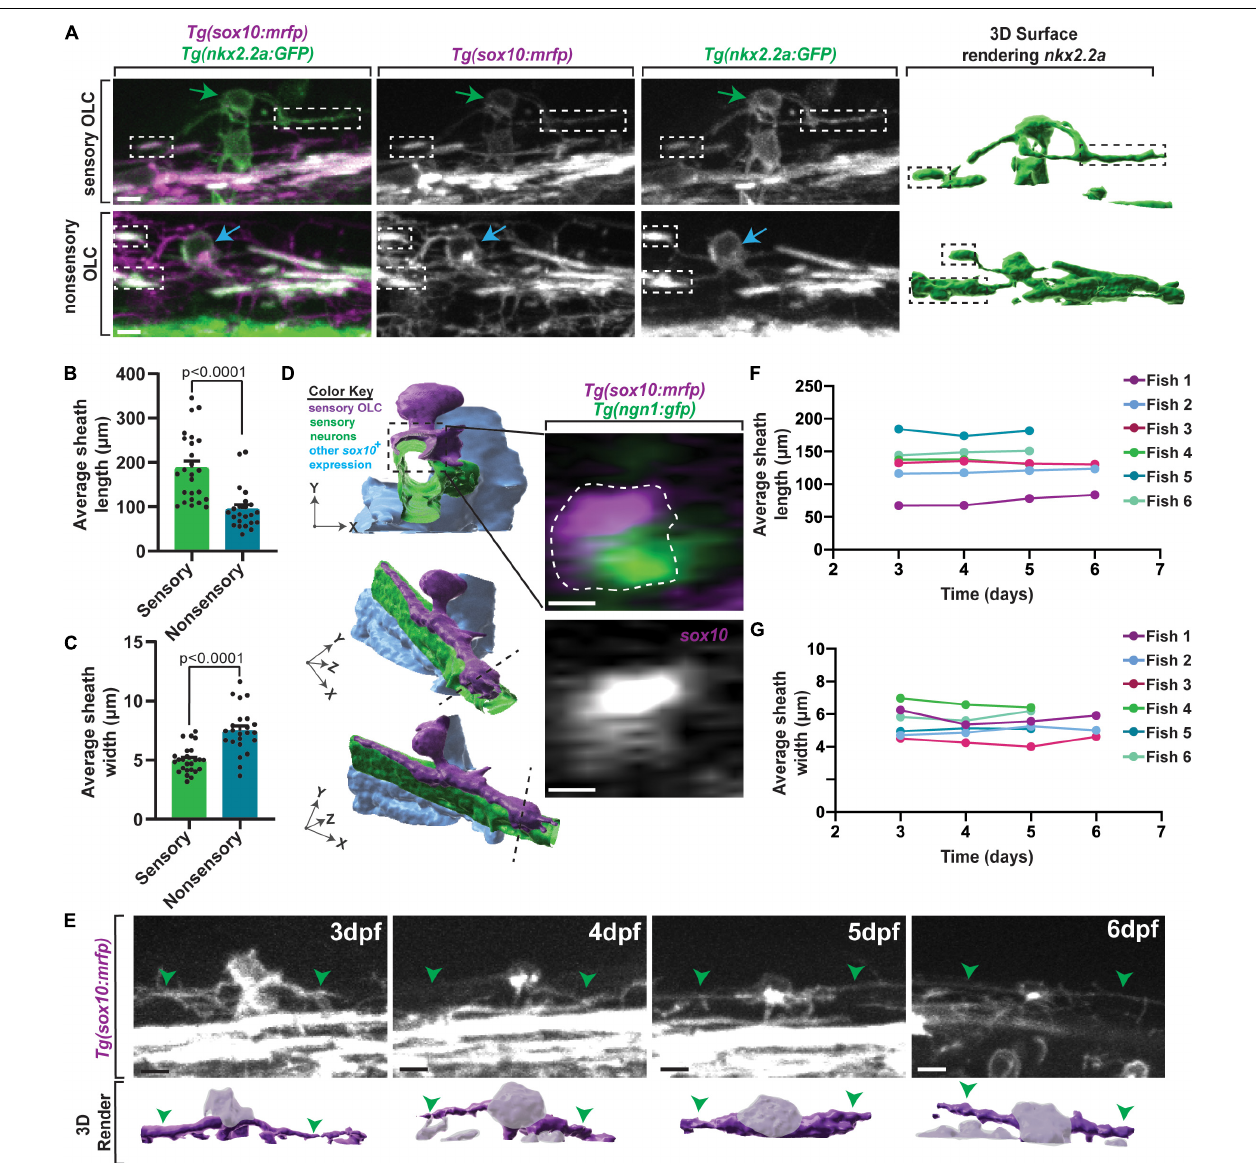
FIGURE 2 | Sensory OLs maintain a distinct sheath profile. (A) Confocal z-stack still images of Tg(nkx2.2a:gfp);Tg(sox10:mrfp) animals at 72 hpf showing the distinct sheath profile of sensory OLs compared to non-sensory OLs. Green arrows represent a sensory OL. Blue arrows represent a non-sensory OL. White and